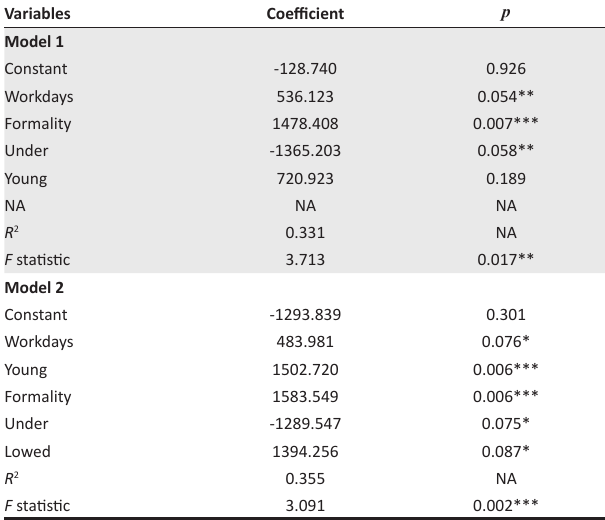
TABLE 2-A1: Income robustness